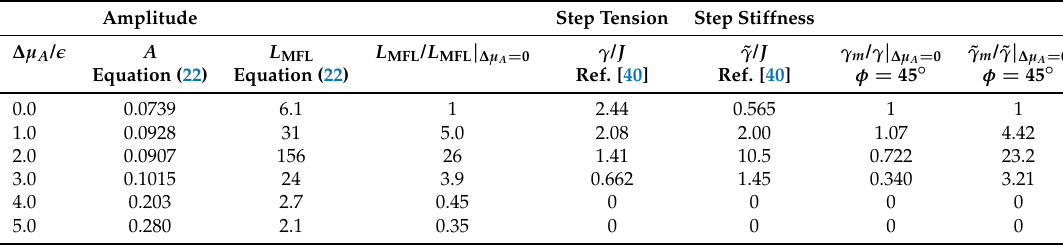
Table 1. Characteristic lengths, step tension, and step stiffness. Step